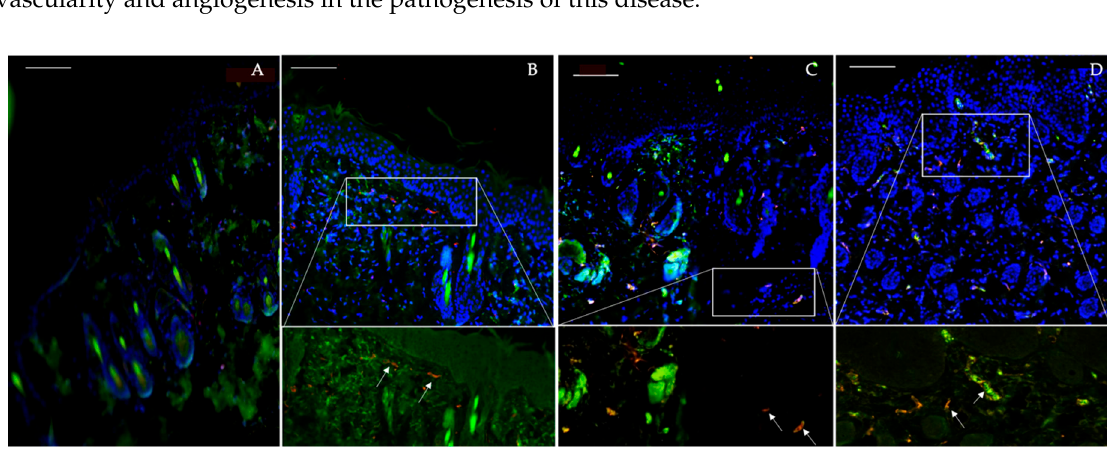
Figure 7. Endothelial markers evaluation in the course of IMQ-induced psoriasis-like dermatitis. Day 2 ( A ), Day 4 ( B ), Day 6 ( C ) and Day 8 ( D ). Blood vessels are presented in red indicating CD31, endothelial cells in green indicating CD34 and cell nuclei in blue by DAPI. Scale bar = 100 µ m.